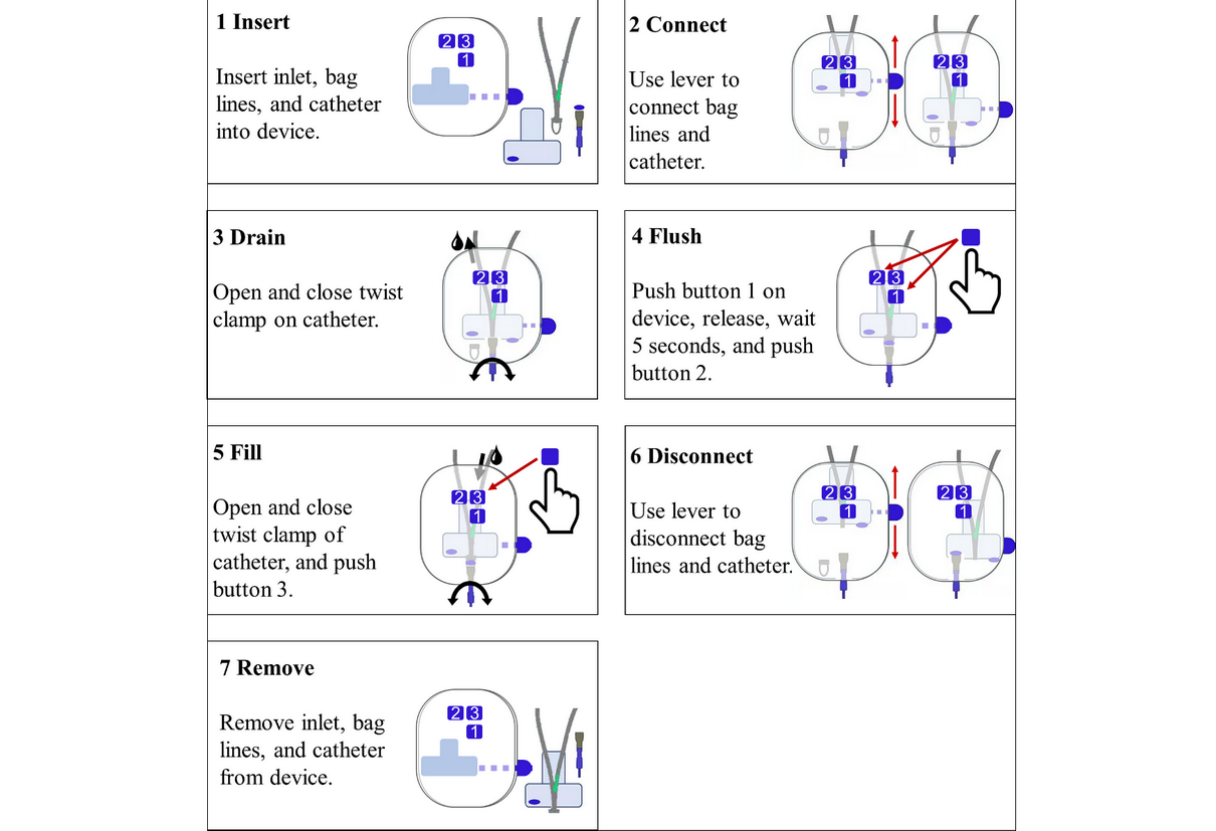
Figure 2. Seven tasks in medical device handling cycle. User interacts manually with inlet, bag lines, catheter, and user interface features lever and buttons